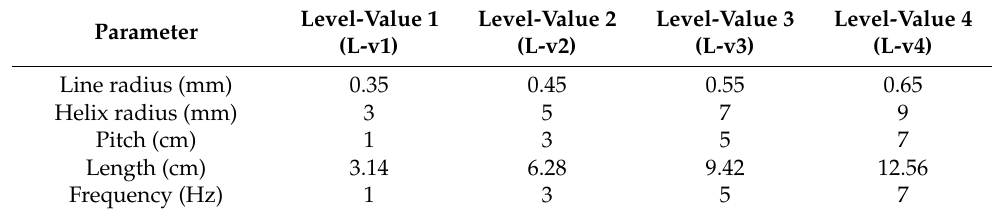
Table A1. Four level-values of each parameter used to make orthogonal analysis and range analysis.